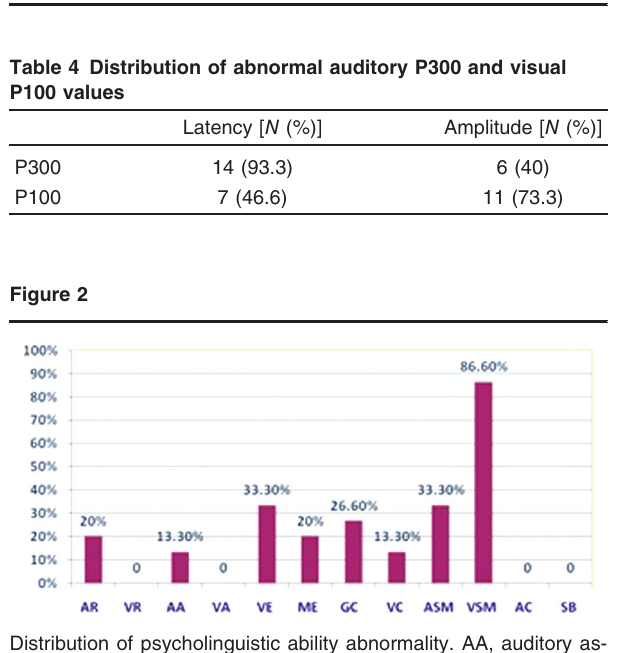
Correlation studies The relationship between central auditory test, and psycholinguistic test results versus electrophysiological measures